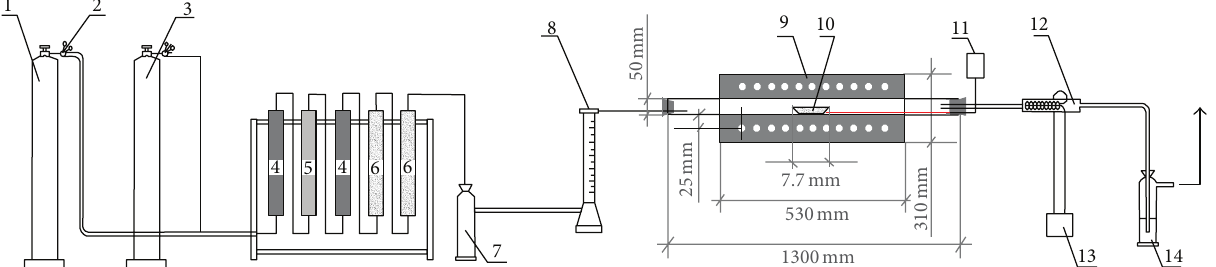
Figure 1: The apparatus used for reduction of NiO and NiCl 2 in static conditions: 1: high-pressure hydrogen bottle, 2: reducing valve, 3: high pressure nitrogen bottle, 4: silica gel column, 5: copper powder column, 6: calcium-chloride column, 7: wash bottle with H 2 SO 4 , 8: rotameter, 9: electric resistance furnace with quartz tube, 10: silica sample carrier, 11: thermocouple, 12: water-cooled condenser, 13: water-cooling system, and 14: wash